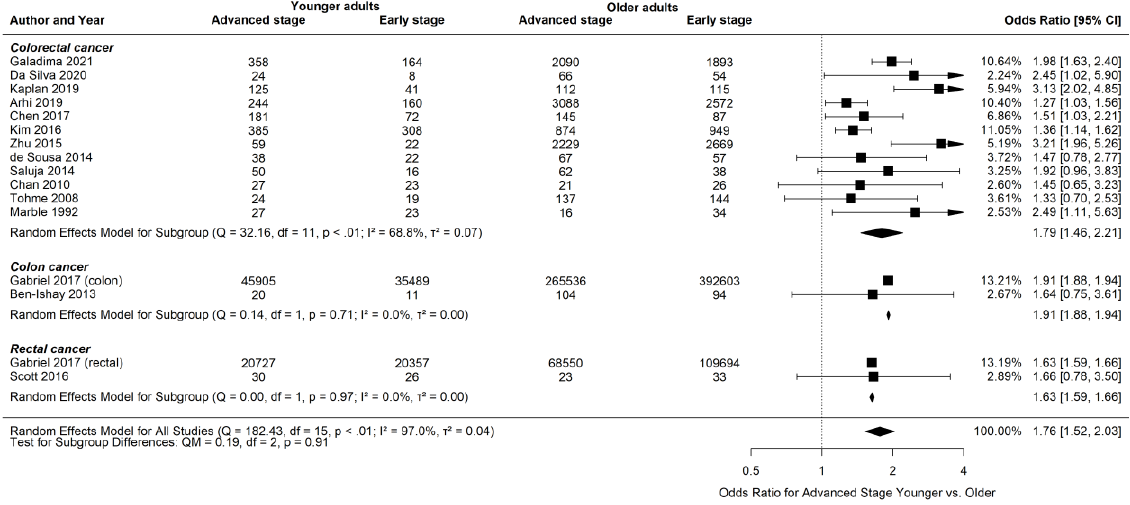
Figure 3. Random effects meta-analysis of advanced stage at diagnosis by age category. Subgroup analyses were performed by type of cancer studied. Advanced stage was defined as Stage III/IV and early stage was defined as Stage I/II. Squares indicate individual study effect sizes with arrows indicating confidence intervals. Black diamonds indicate pooled effect sizes and confidence intervals.